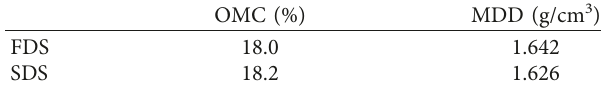
Figure 9: Moisture-density curves of SDS and FDS. Table 6: The OMC and MDD of SDS and FDS.